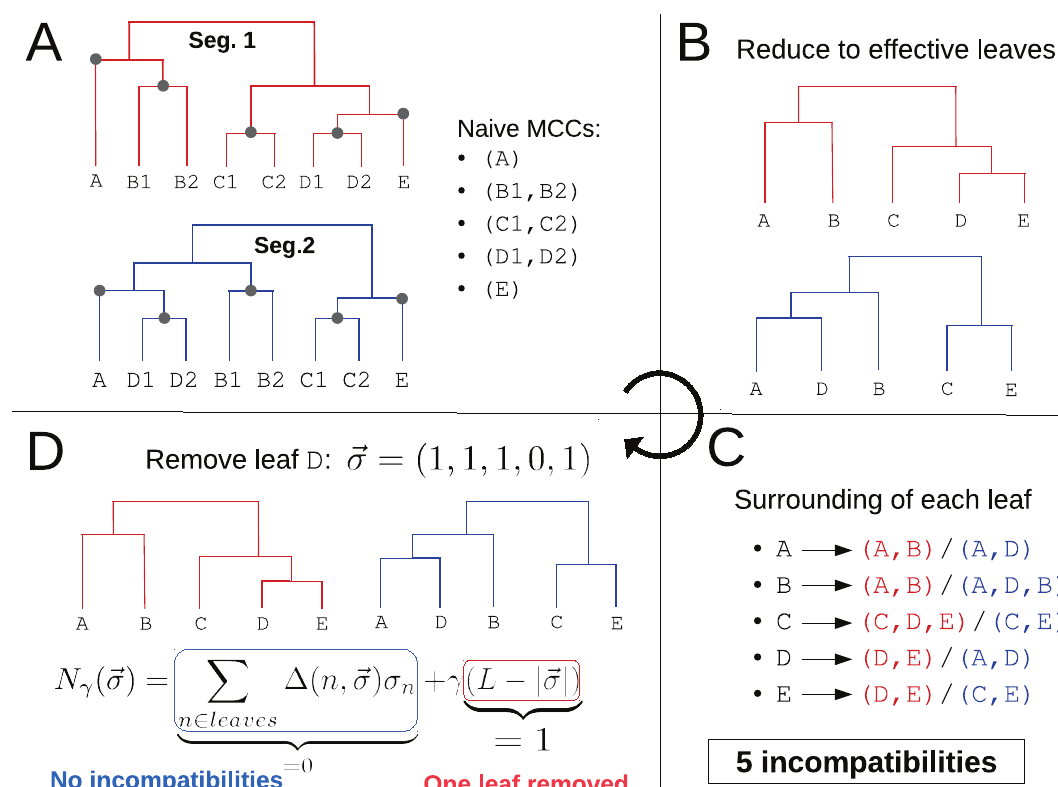
Fig 2. Schematic of the iterative algorithm. A : Construction of the naive MCCs. Circles indicate the root of the five clades that match exactly in the two trees (slightly highlighted branches). Trying to grow one of these clades gives inconsistent results in the two trees: e.g . growing the MCC (B1,B2) gives clade (A,B1,B2) in the first tree and (A,D1,D2,B1,B2) in the second. B : Trees obtained after reducing trees of A to their naive MCCs: each clade is represented by a single effective leaf. C : Counting incompatibilities in the reduced trees. For each effective leaf, the clades defined by its direct ancestor in the two trees are compared, and each mismatch counts as one incompatibility. D : Enforcing reassortments on some leaves to remove incompatibilities. A configuration ~ s is associated to each set of removed leaves. The scoring function N ð ~ s Þ adds the number of remaining g incompatibilities given ~ s and the number of removed leaves multiplied by γ . The optimal set of reassortments is found by minimizing N ð ~ s Þ , e.g . removing D is optimal if γ < g